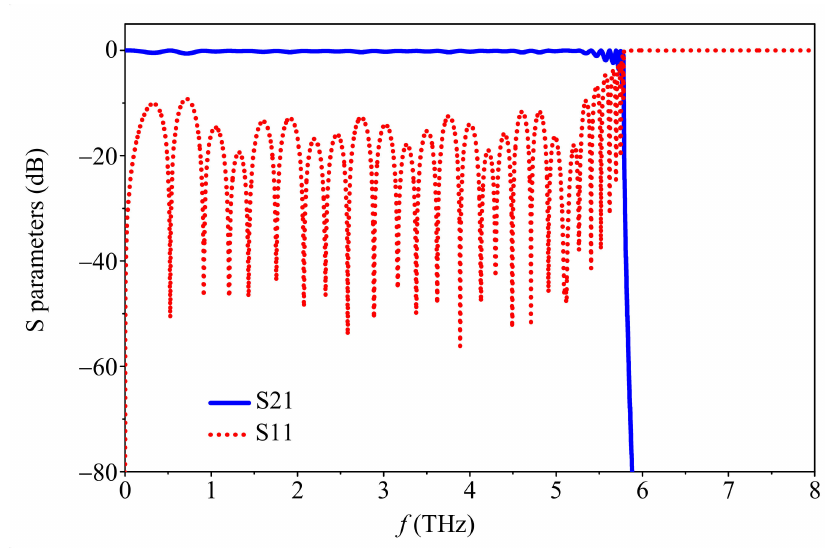
Figure 4. Simulated S-parameters of the terahertz windmill-shaped SSPP waveguide.